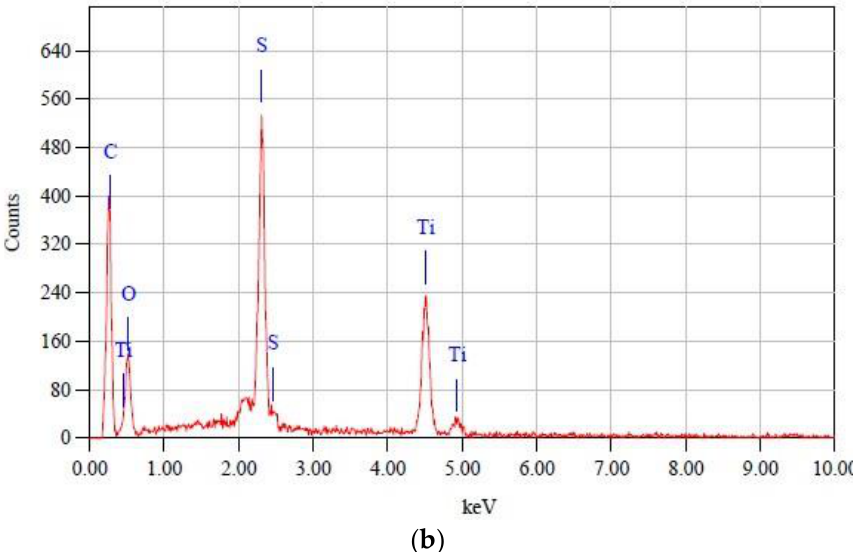
Figure 5. ( a ) EDX spectrum of a neat PES membrane; and ( b ) EDX spectrum of the TiO 2 /PES mixed matrix membrane.